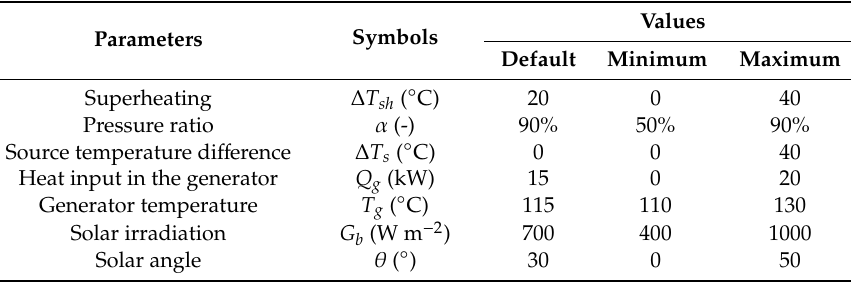
Table 3. Parametric analysis